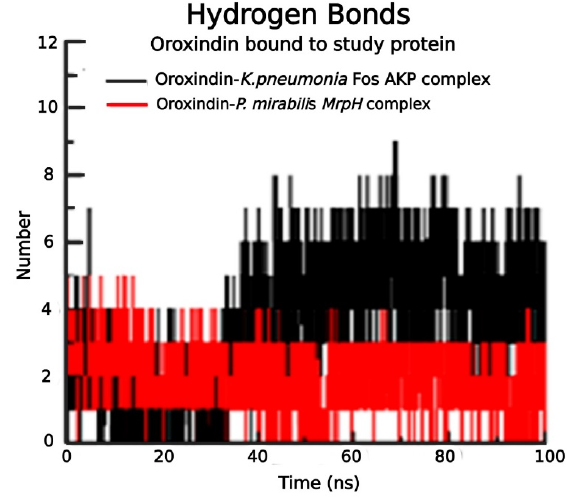
Figure 6. Hydrogen bond interactions of Oroxindin in complex with 5WEW and 6Y4F.